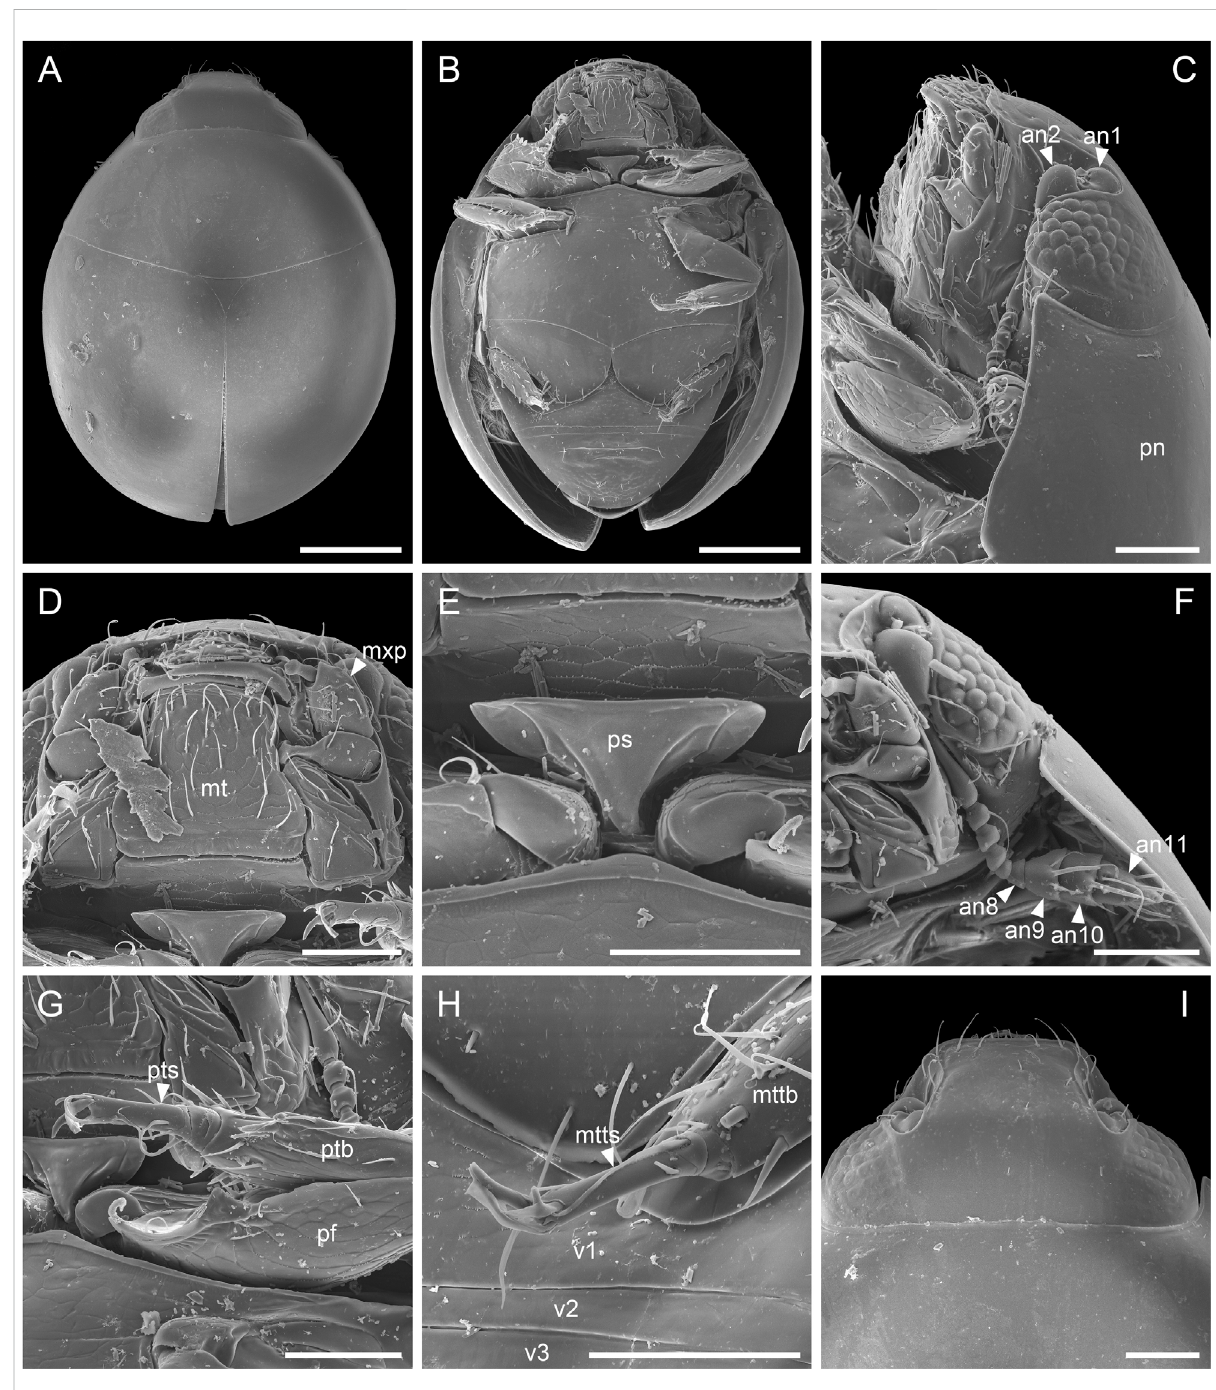
FIGURE 6 Extant Sphaerius sp. from Australia, under scanning electron microscopy. (A) Habitus, dorsal view. (B) Habitus, ventral view. (C) Head and prothorax, lateral view. (D) Mouthparts, ventral view. (E) Prosternum, ventral view. (F) Antenna. (G) Fore leg. (H) Metatarsus. (I) Head, dorsal view. Abbreviations: an1 – 11, antennomeres 1 – 11; mt, mentum; mttb, metatibia; mtts, metatarsus; mxp, maxillary palp; pf, profemur; pn, pronotum; ps, prosternum; ptb, protibia; pts, protarsus; v1 – 3, ventrites 1 – 3. Scale bars: 150 μ m in (A,B) , 50 μ m in (C – I)